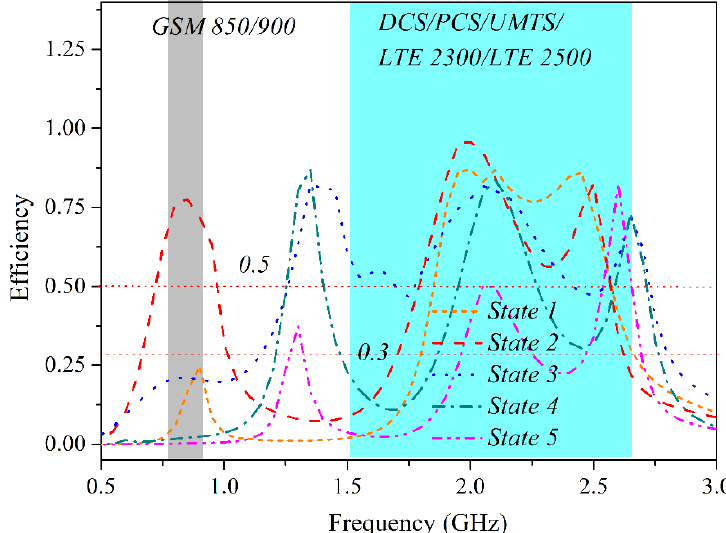
Figure 11. Measured result of five |S 11 |: State 2 for lower bands and the other four states for mid and high bands. Electronics 2018 , 7 , x FOR PEER REVIEW